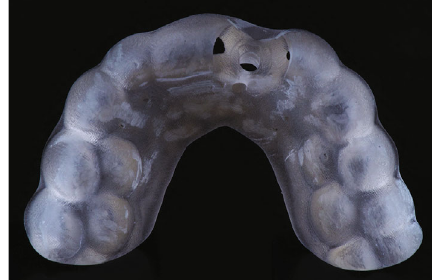
Figure 5: Printed surgical